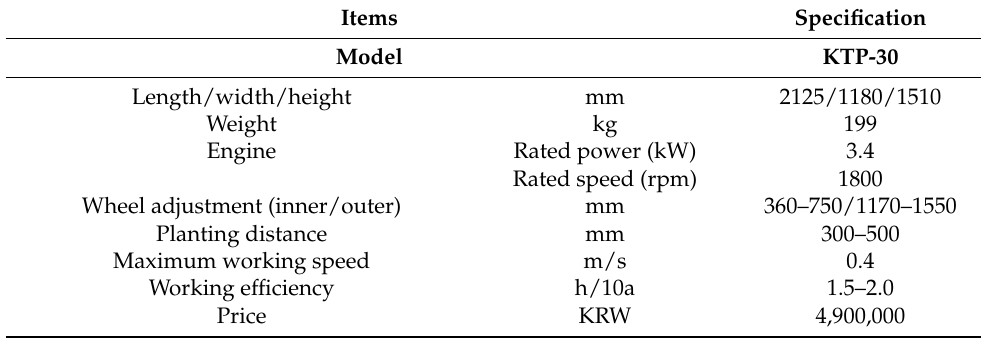
Table 2. Main specifications of the four-bar-link semi-automatic vegetable transplanter.